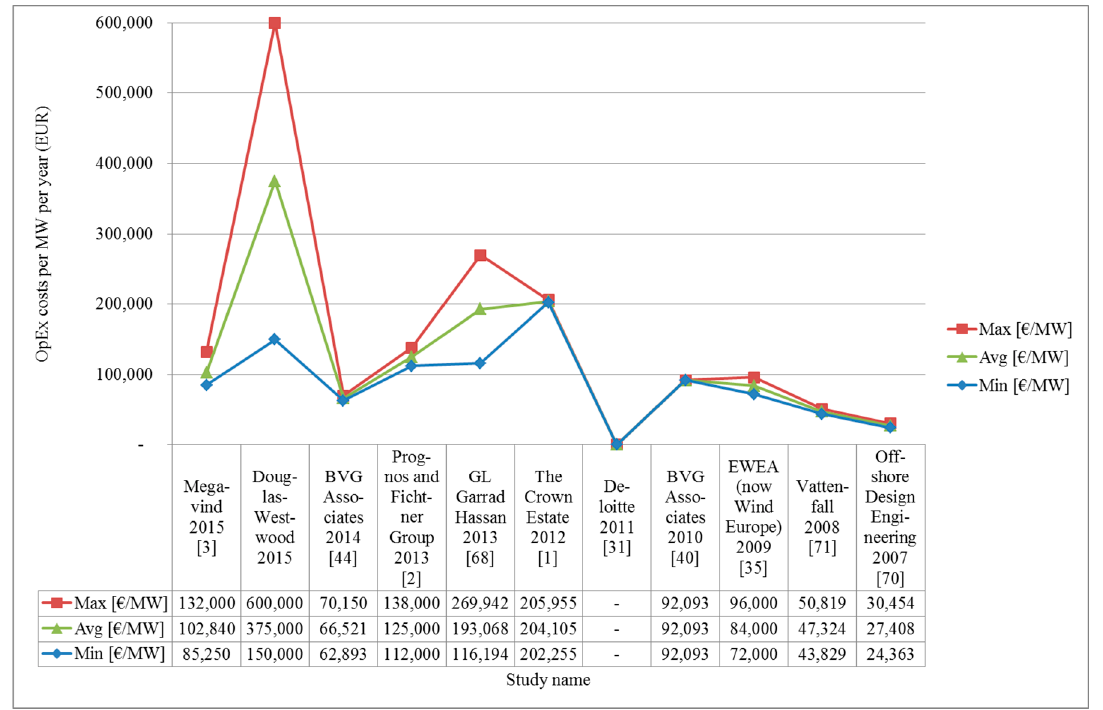
Figure 2. Calculated annual OpEx cost ranges per mega-Watt for the eleven studies.